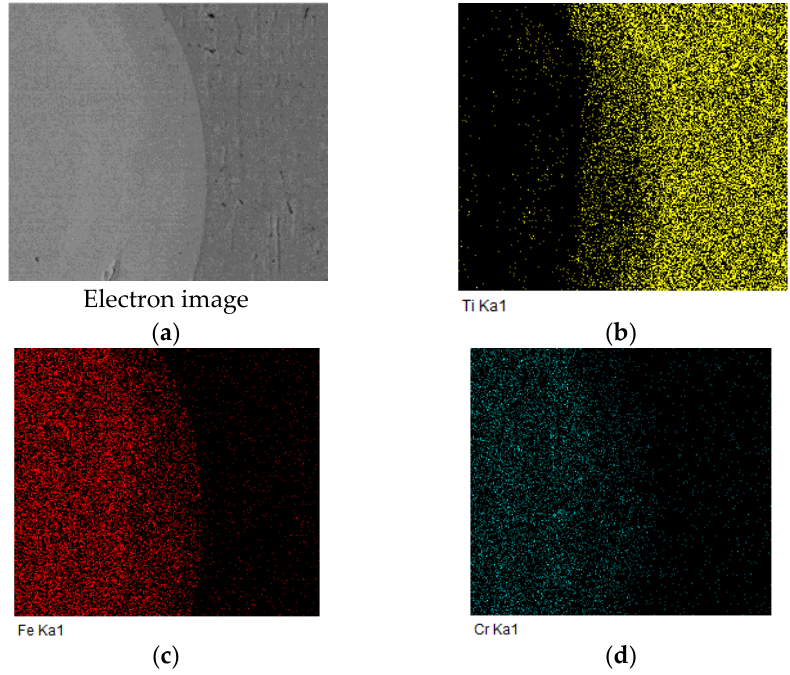
Figure 8. Distribution of elements near the interface ( a ) Electron image, ( b ) Ti, ( c ) Fe, and ( d ) Cr. Metals 2018 , 8 , x FOR PEER REVIEW 13 of 16